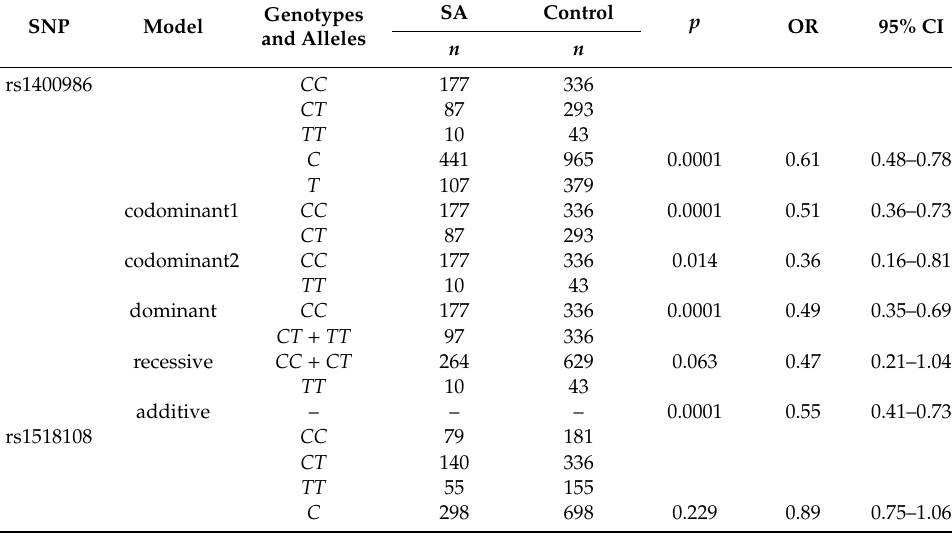
Table 3. Association between IL-20 gene polymorphisms and subclinical